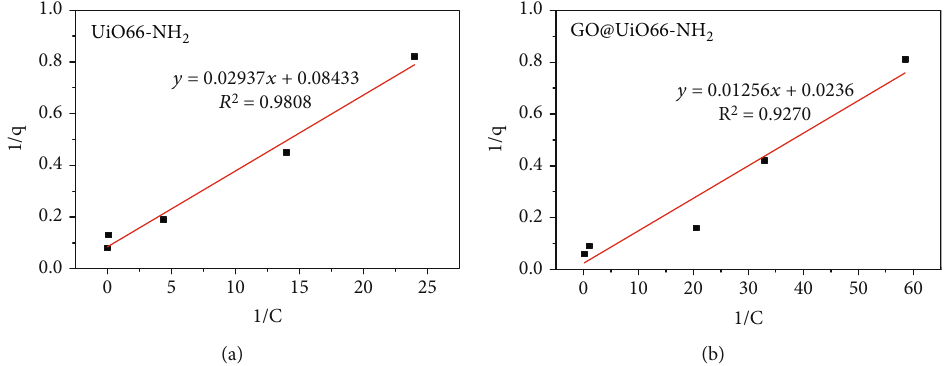
Figure 6: The Langmuir adsorption isotherms of (a) UiO-66-NH